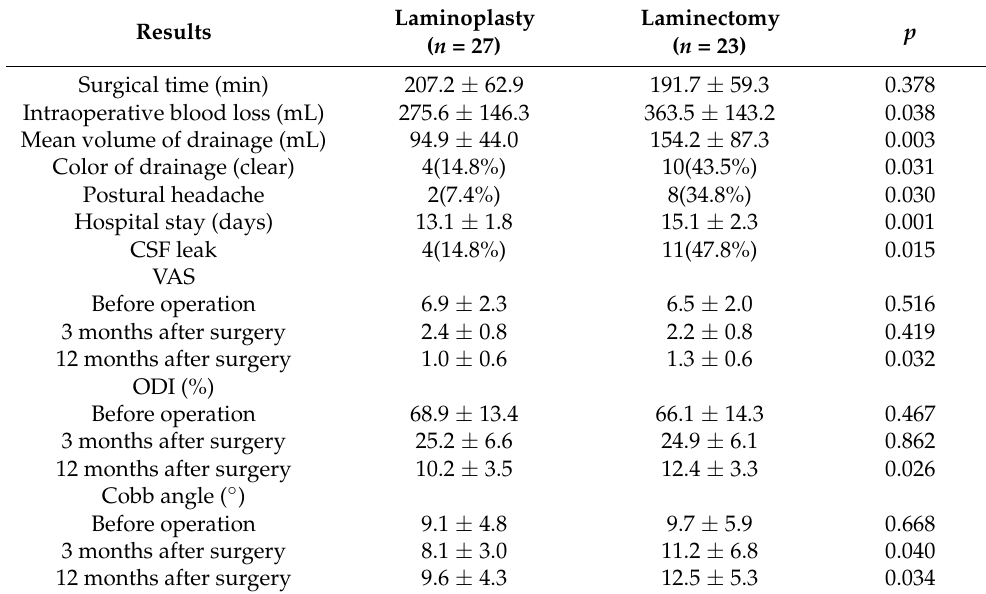
Table 2. Comparison of the surgical and follow-up results between the two groups.